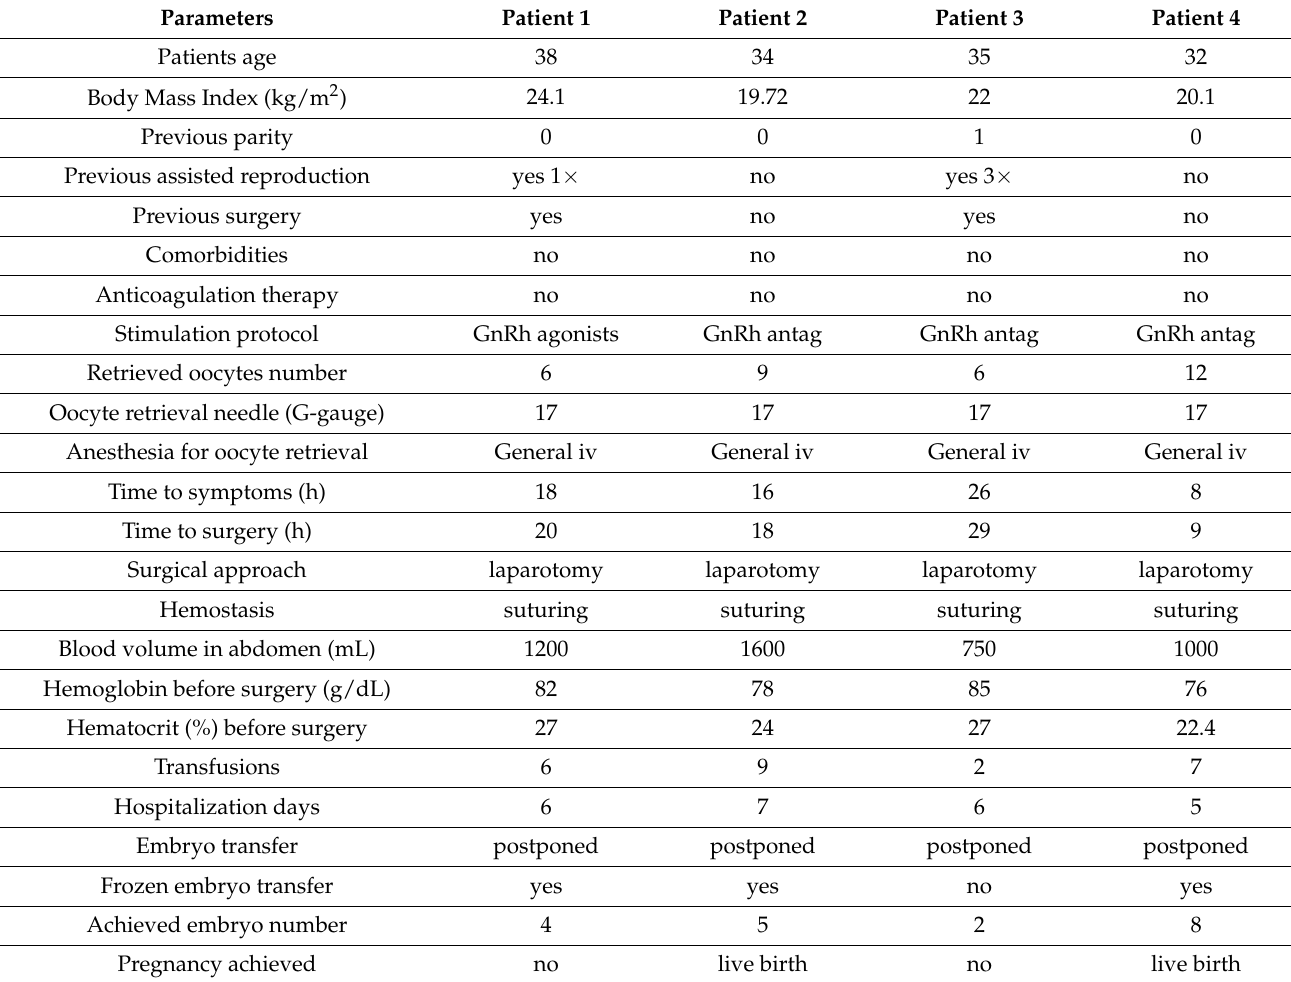
Table 1. Investigated parameters of patients from our